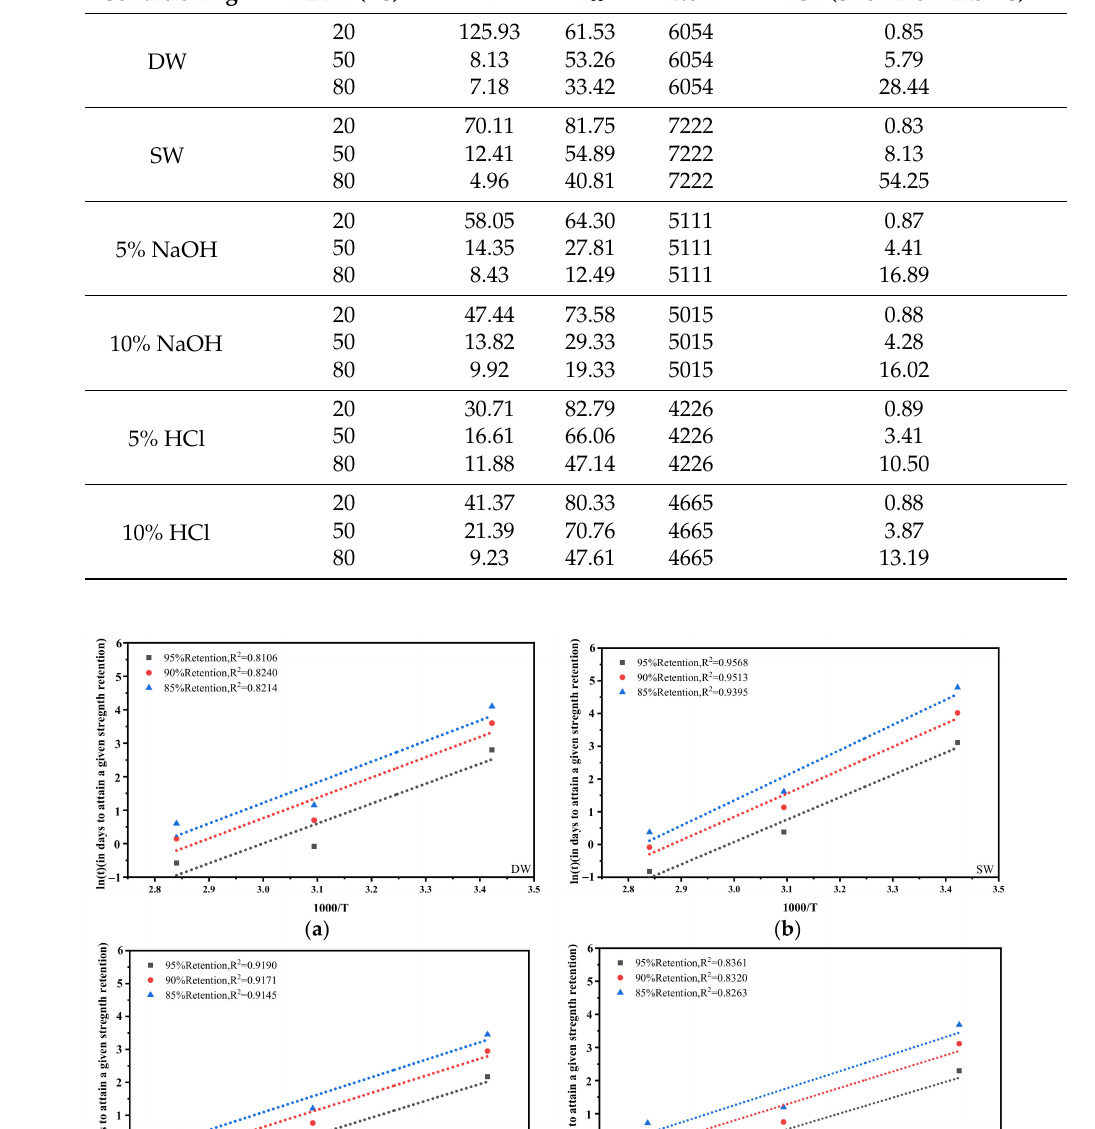
Table 3. Regression coefficients in Equation (4) and time shift factors (TSF) for the GFRP specimens. Conditioning